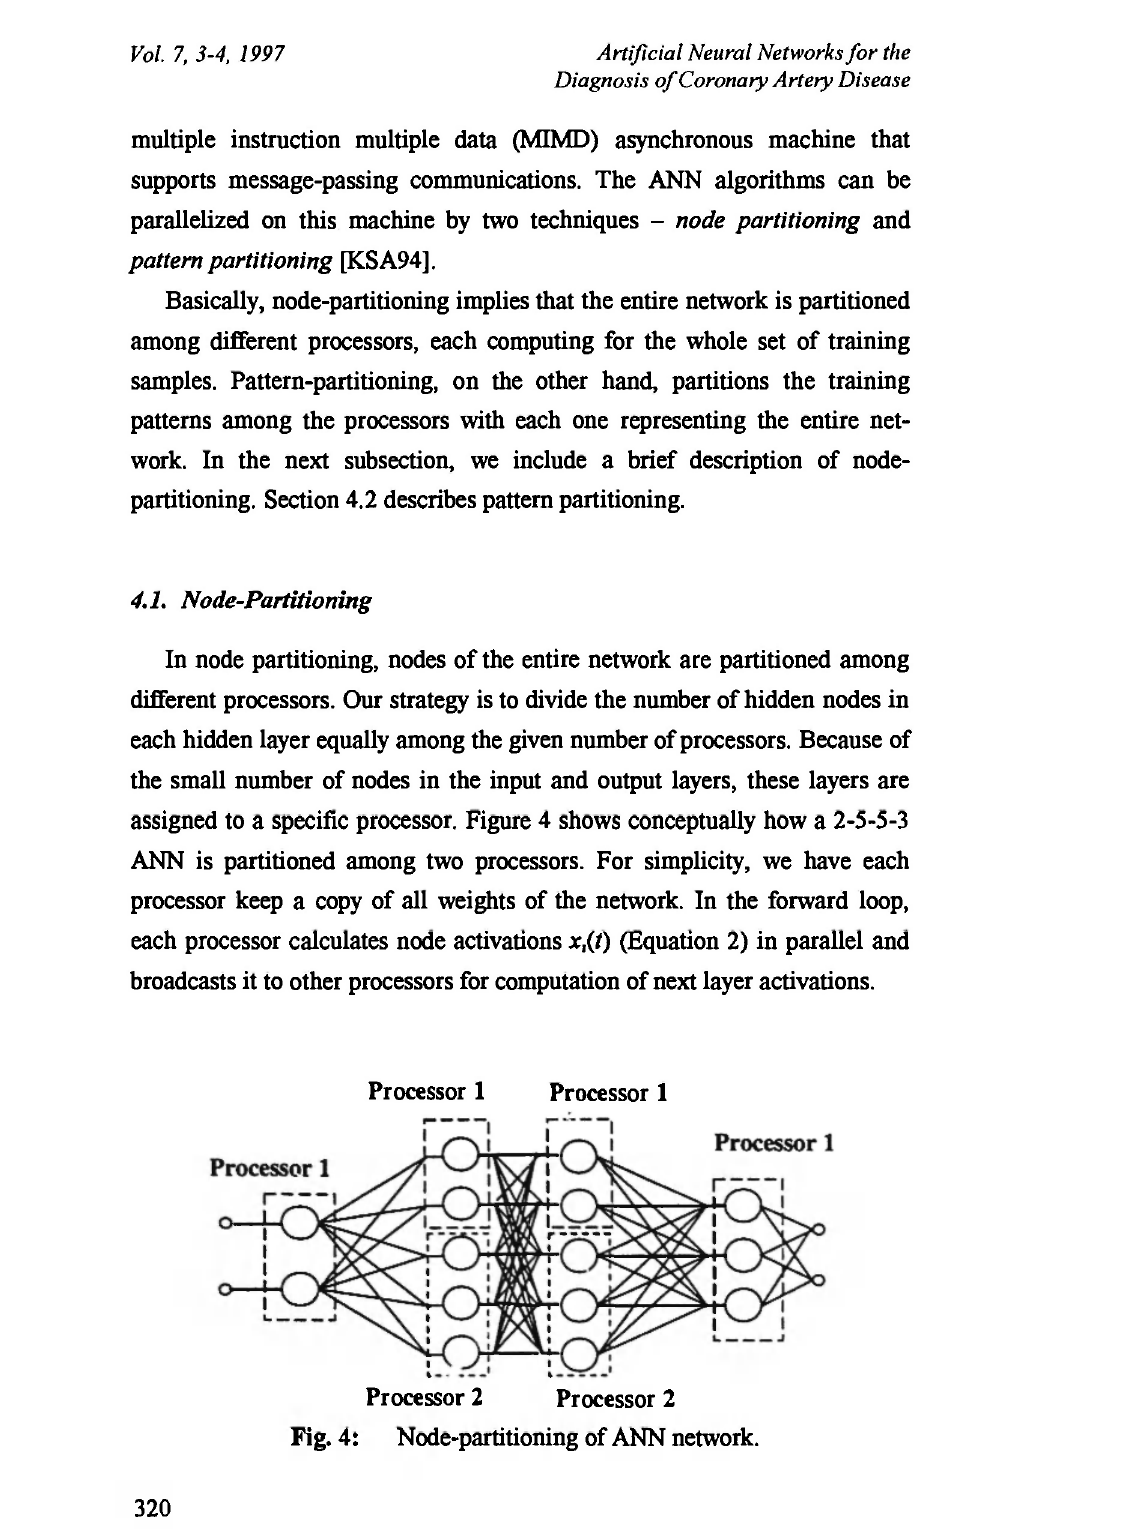
Fig. 4: Node-partitioning of ANN